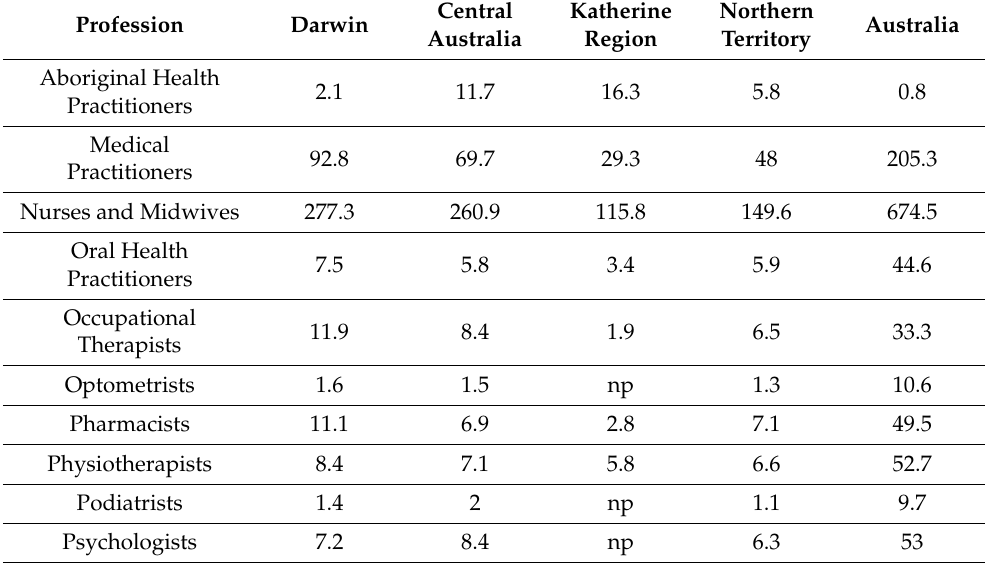
Table 2. Availability of health workforce, per 10,000 population, 2019